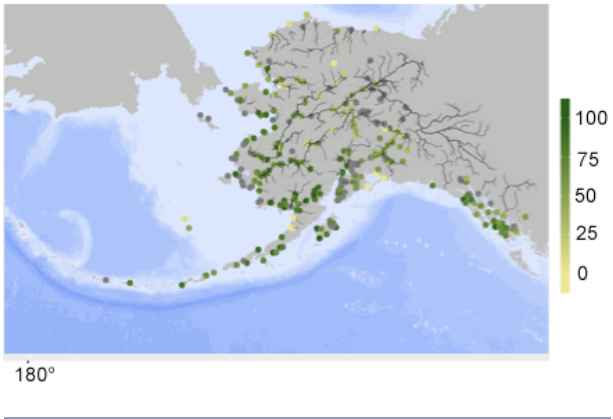
Fig. 3. Percentage of households by community who harvest salmon for subsistence (Clark et al.